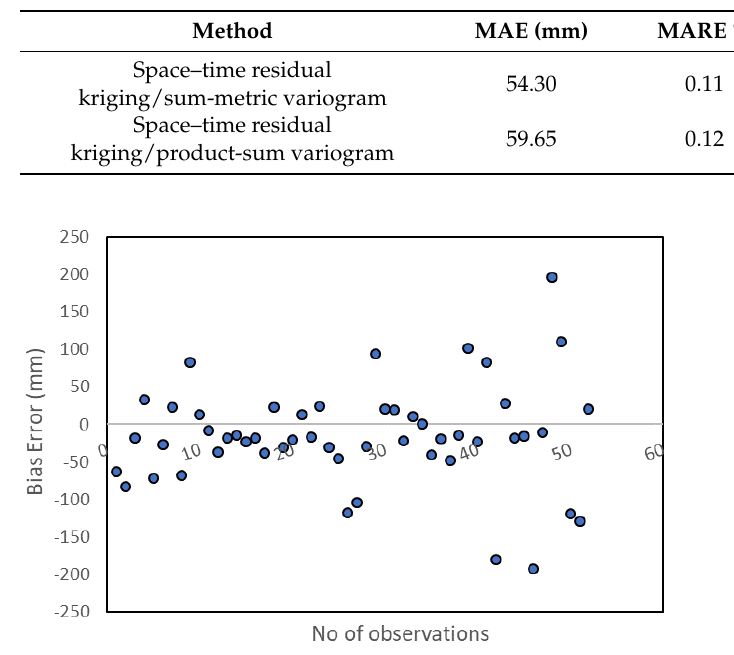
Figure 4. Bias performance of STRK method for the hydrological year 2016/17.